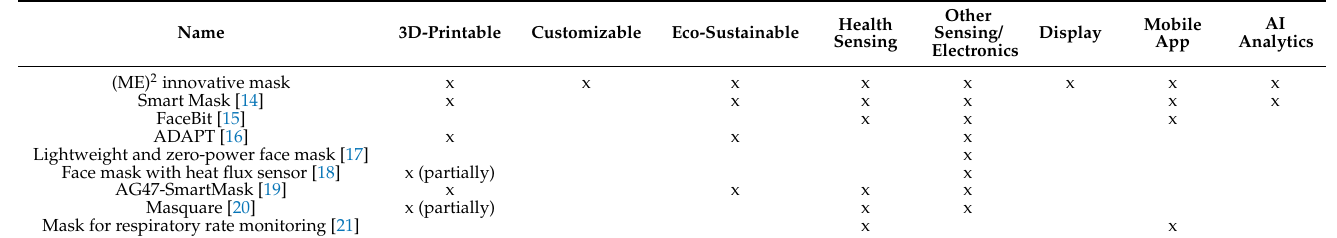
Table 1. Smart Mask in comparison to other solutions. x indicates that the prototype has the corresponding